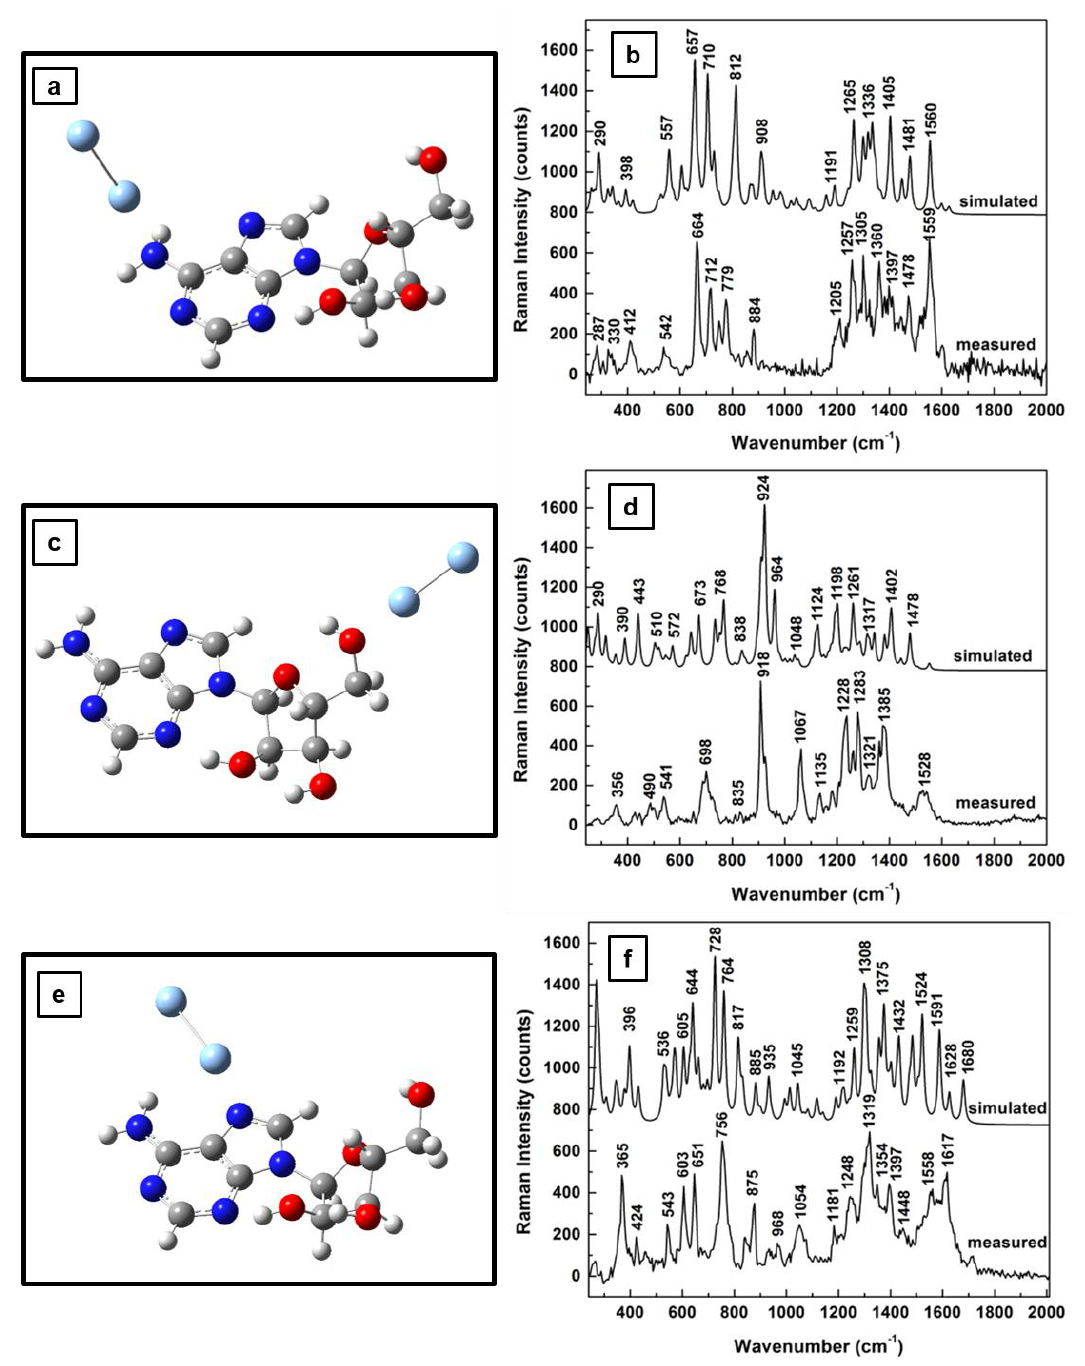
Figure 2. ( a , c , e ) Adenosine structural representation after energy optimization for silver dimer in the proximity of the NH 2 site of the adenine ring, in the vicinity of the carbinol moiety, and between the OH and NH 2 chemical bonds of the adenine and ribose structural units, respectively. ( b , d , f ) theoretically estimated and experimentally recorded Raman vibrational spectra of neutral adenosine associated with ( a , c , e ), respectively. The spectra are vertically translated for easier visualization and appropriately labeled.